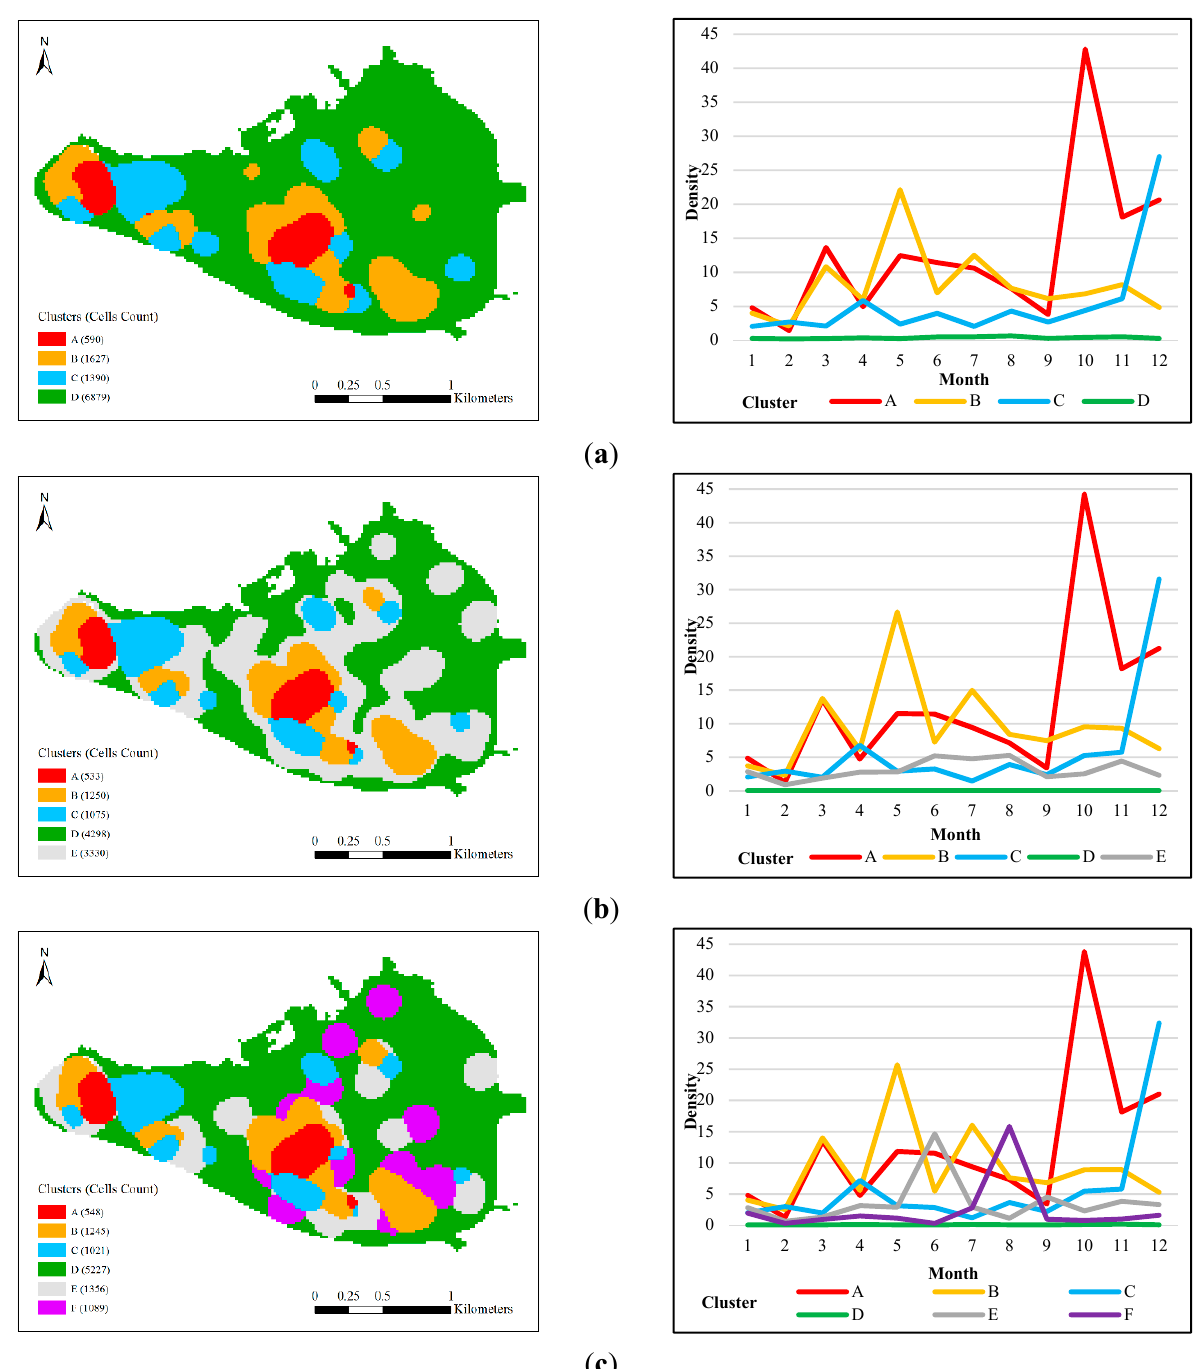
Figure 5. The STICA results of burglary density. ( a ) four clusters; ( b ) five clusters; ( c ) six